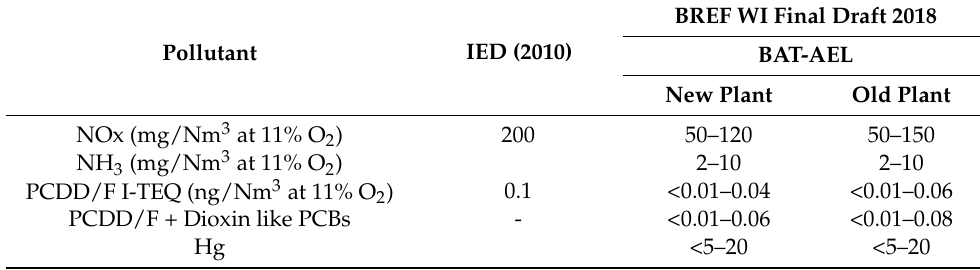
Table 8. Applicable emissions for waste-to-energy (WtE) plants in Europe [13,28].